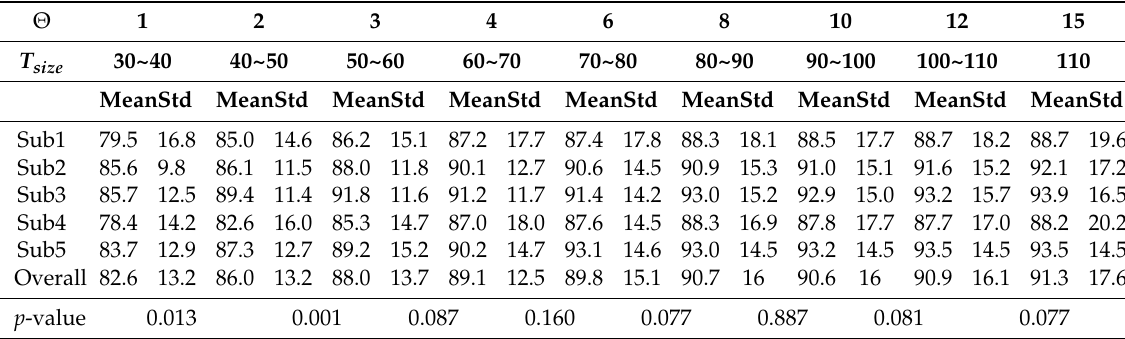
Table 5. Recognition accuracies (%) of 110 CSL sign words at different sizes of training set (Sub3 as reference